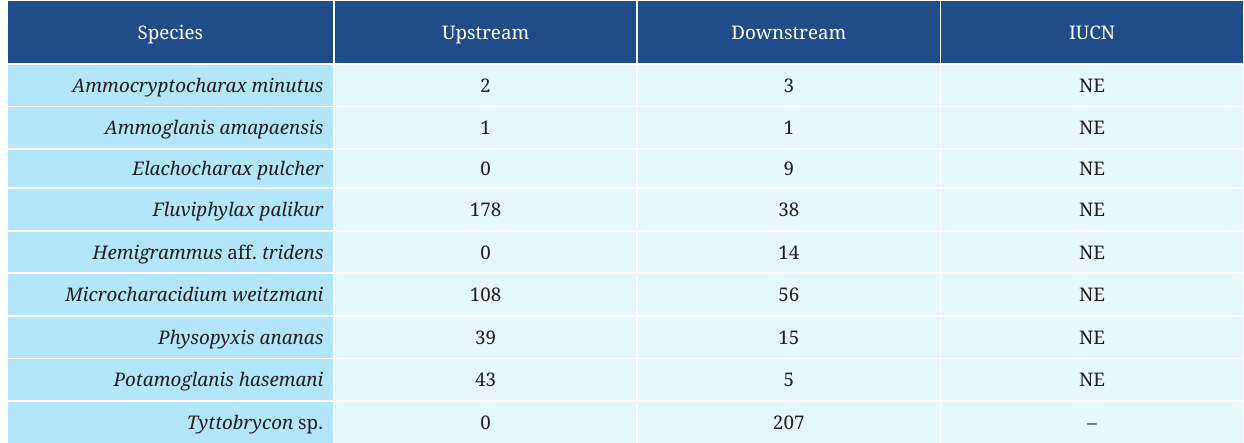
TABLE 2 | Abundances of miniature fish species collected at the upstream and downstream sampling sites (see Fig. 1 for locations) and conservation status according to the International Union for the Conservation of Nature (IUCN). NE = Not